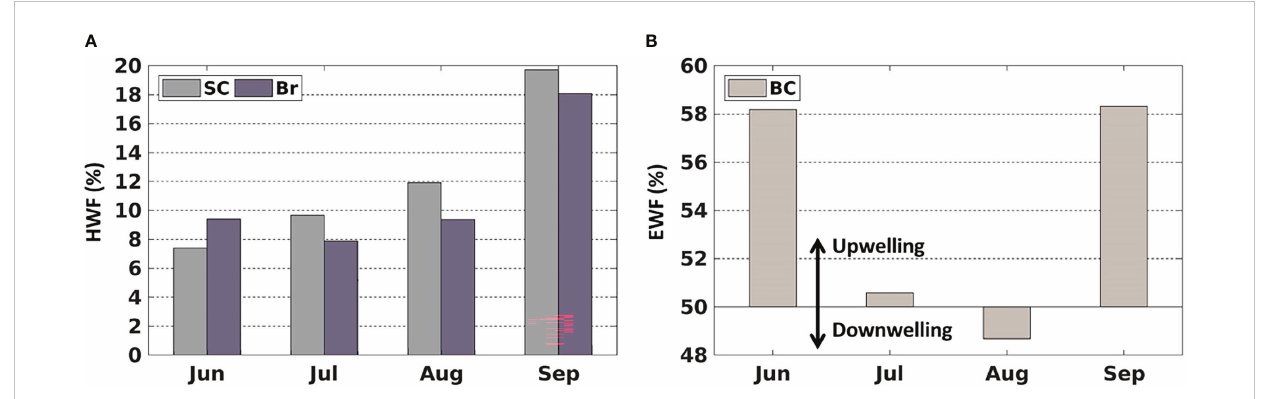
FIGURE 5 Average monthly (1990-2014) (A) high wind frequency (HWF) in the SC and Br and (B) easterly wind frequency (EWF) in the